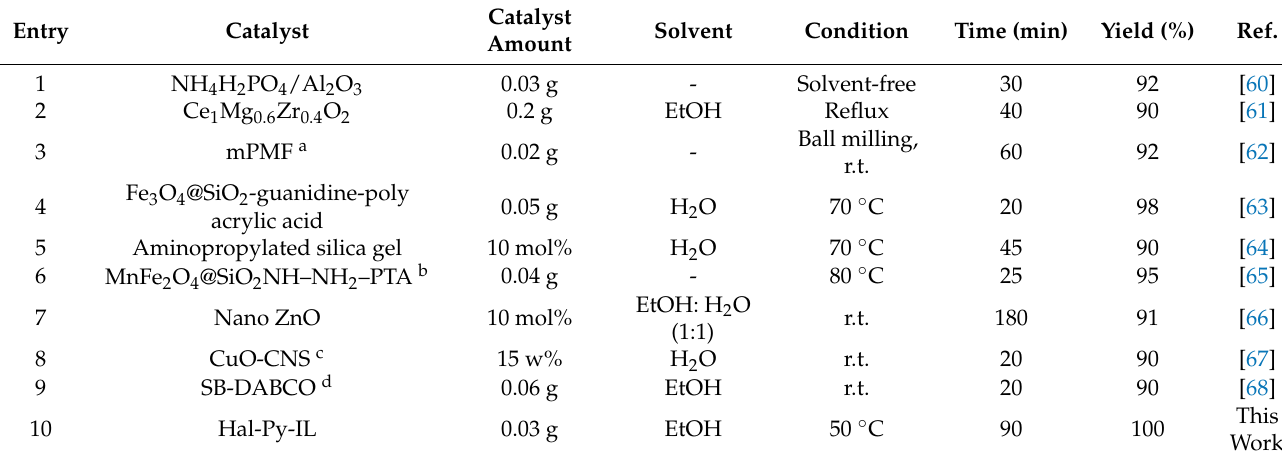
Table 4. Comparison of the activity of Hal-Py-IL with other catalysts for the synthesis of the model product.